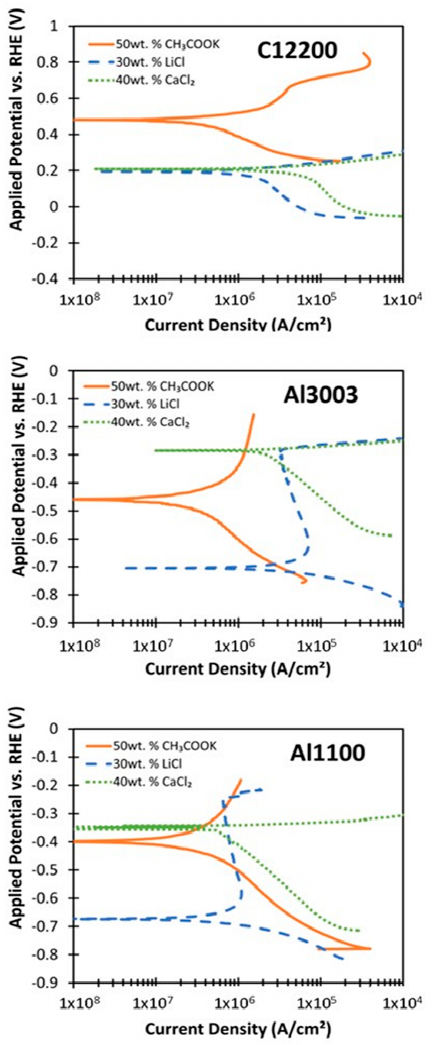
Figure 5. Examples of potentiodynamic polarization curves used to evaluate corrosion behavior of metal alloy samples in various liquid desiccants. Data shown is for experiments at 80 ◦